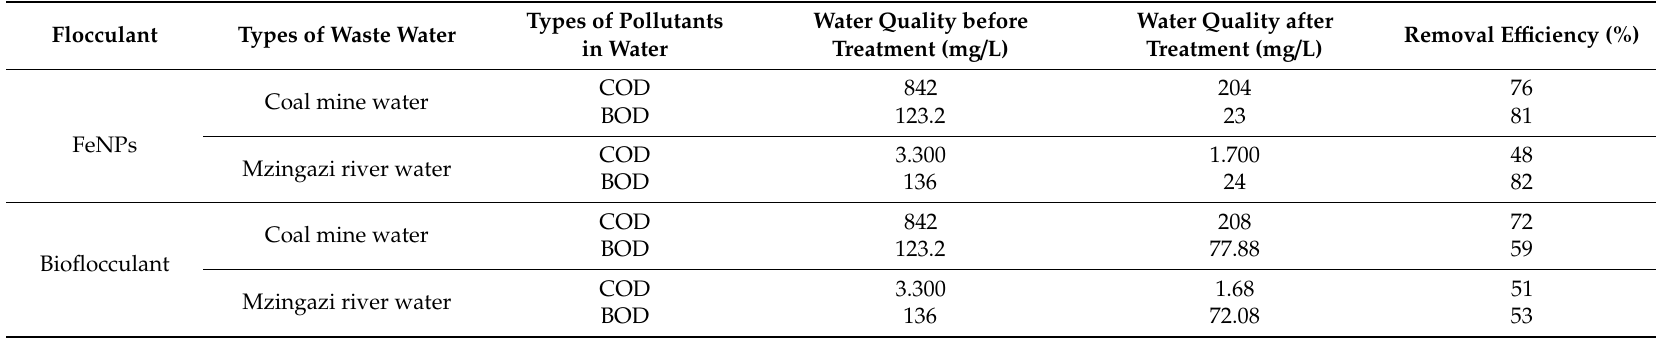
Table 3. Chemical oxygen demand (COD) and biochemical oxygen demand (BOD) removal in wastewater by the bioflocculant and iron